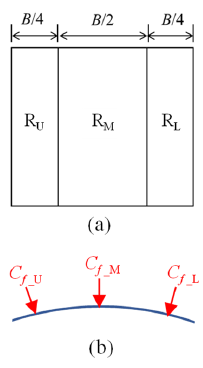
Figure 11. Zoning of vaulted free roof: ( a ) Plan; ( b ) section. Table 1. Area-averaged equivalent wind force coefficients.